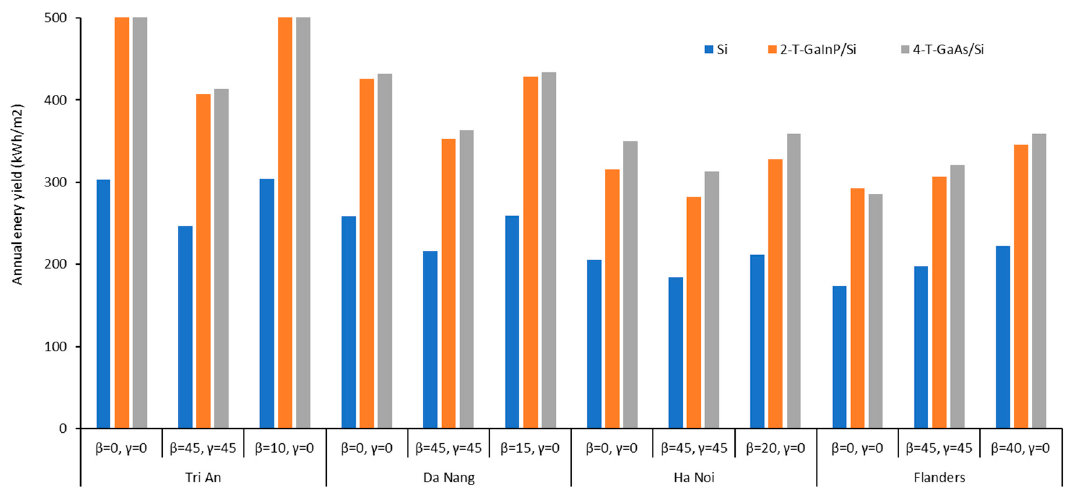
Figure 11. Comparison between annual yield in various orientations of different PV technologies.